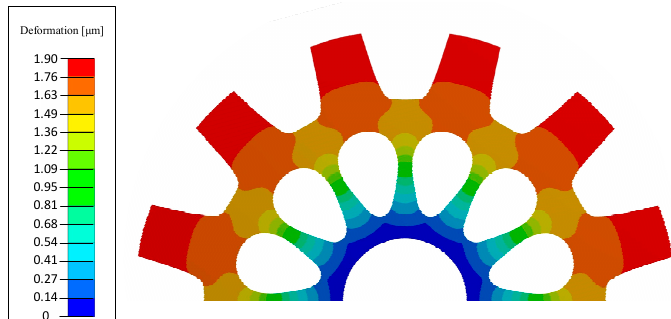
Figure 18. Total deformation analysis with rotor cutouts at 4500 rpm.